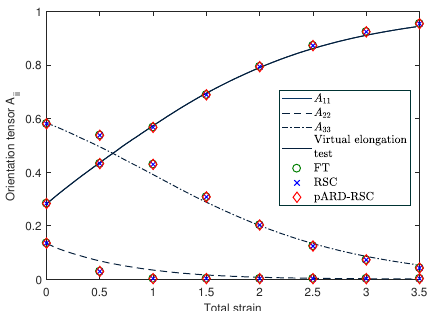
Figure 11. Comparison of the best fit of the FT, RSC, and pARD-RSC model with the virtual elongational test for PP-GF30. Simulation settings are stated in Table